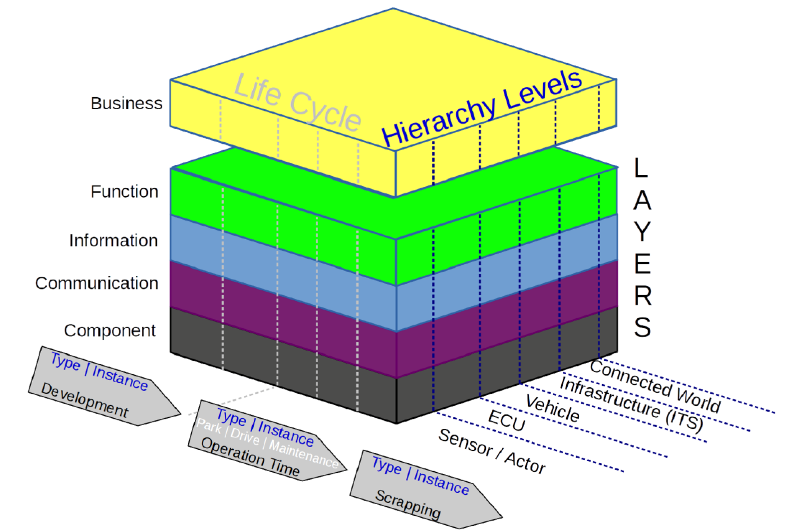
Figure 15. RAMA (Reference Architecture Model Automotive)